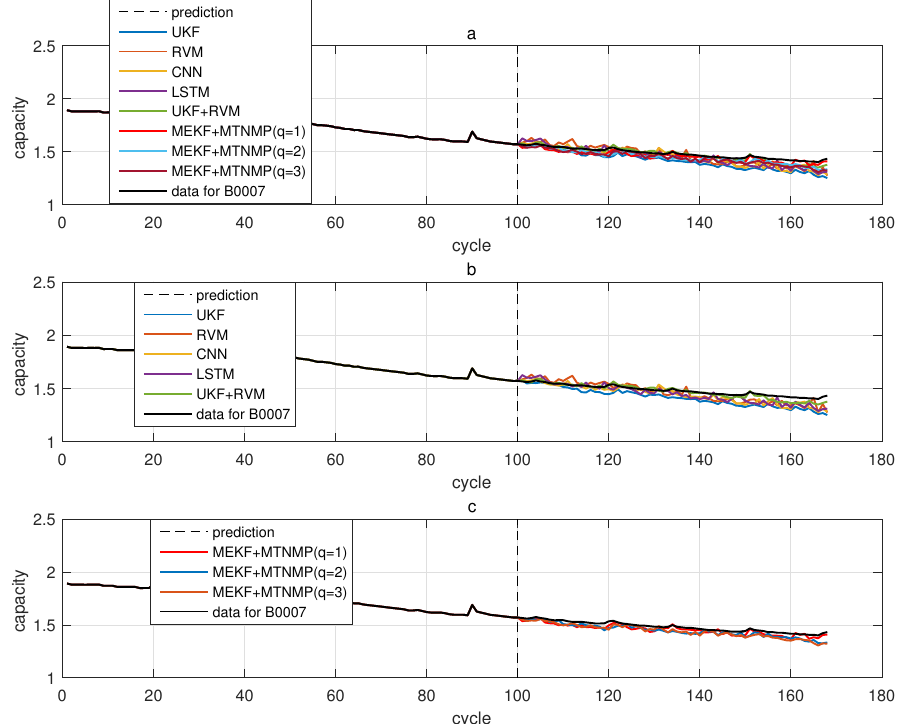
Figure 14. The simulation diagram of B0007 predicted from the 100th time. ( a ) is the experimental diagram of all methods, ( b ) is other methods used for comparison in ( a , c ) is the method proposed in this paper in ( a